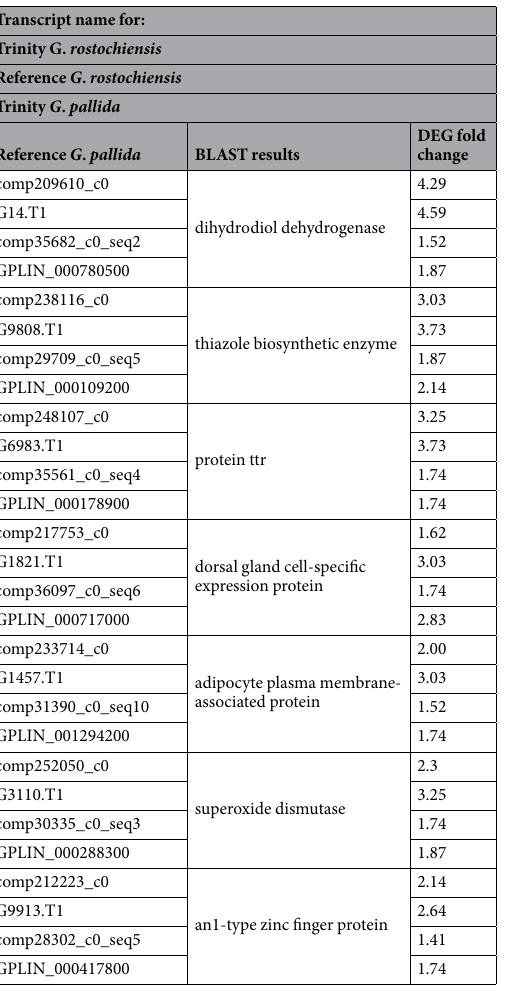
Table 1. Differentially expressed genes (DEGs, P < 0.05, FDR < 0.1) up-regulated in dry cysts common to both G . rostochiensis and G . pallida in both de novo and reference